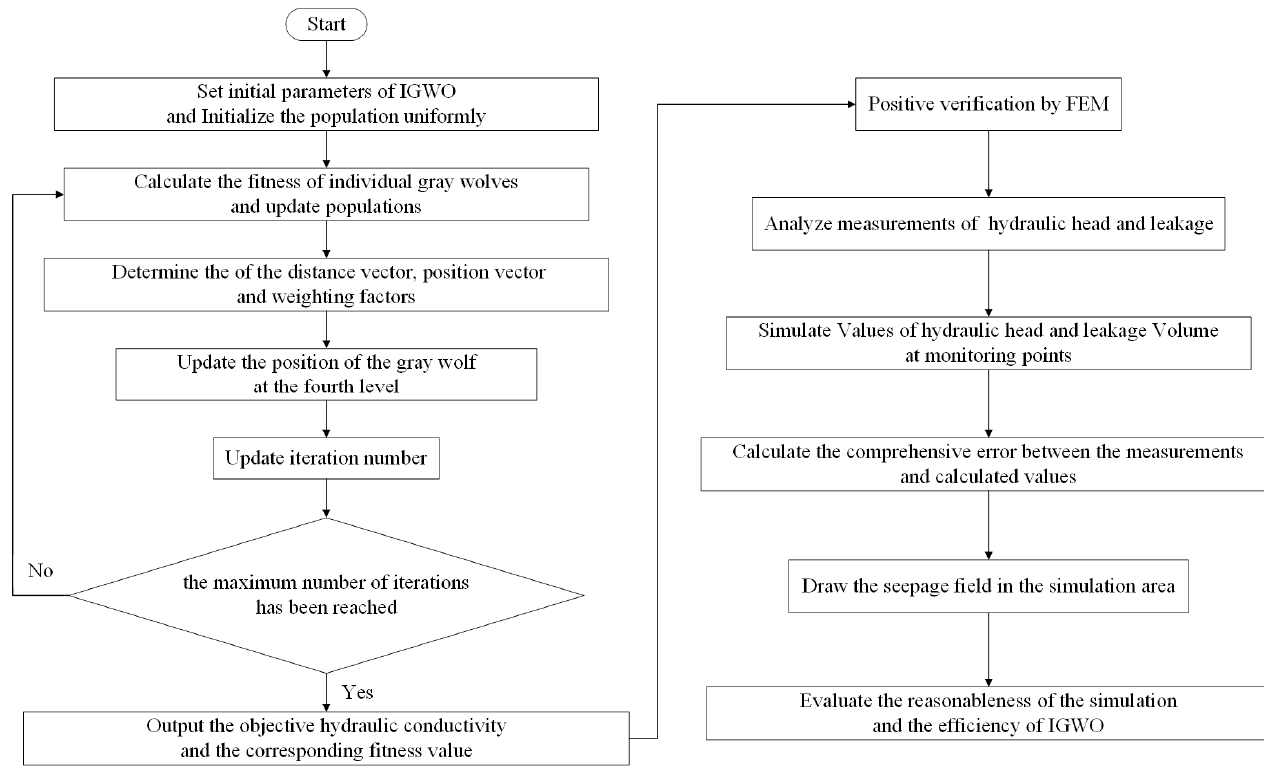
Figure 3. Flow chart of the inverse model based on IGWO.